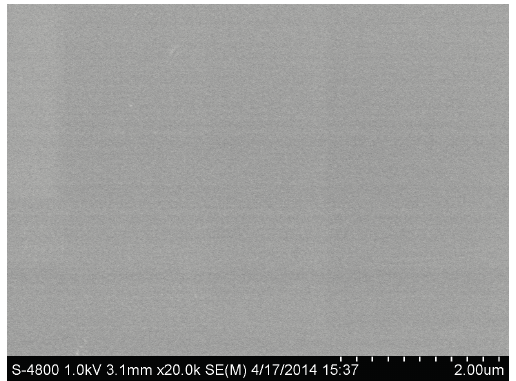
Figure 3. SEM images of bare ( A ) and AuNPs-modified MAE ( B ).